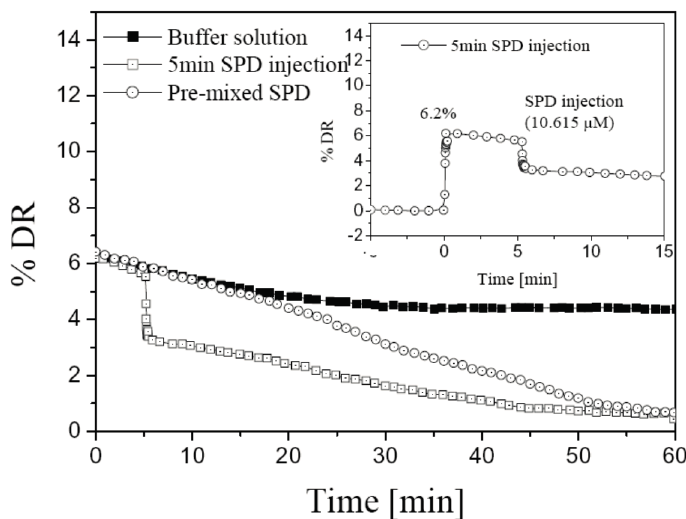
Figure 10. The percent drag reduction versus time for 1.35 wppm λ -DNA in buffer solution at 1157 rpm ( N Re = 5.9 ×10 5 ) and 25 °C with and without spermidine (SPD). The inset shows the magnification of initial change of DR by SPD injection (Reprinted from [66]).